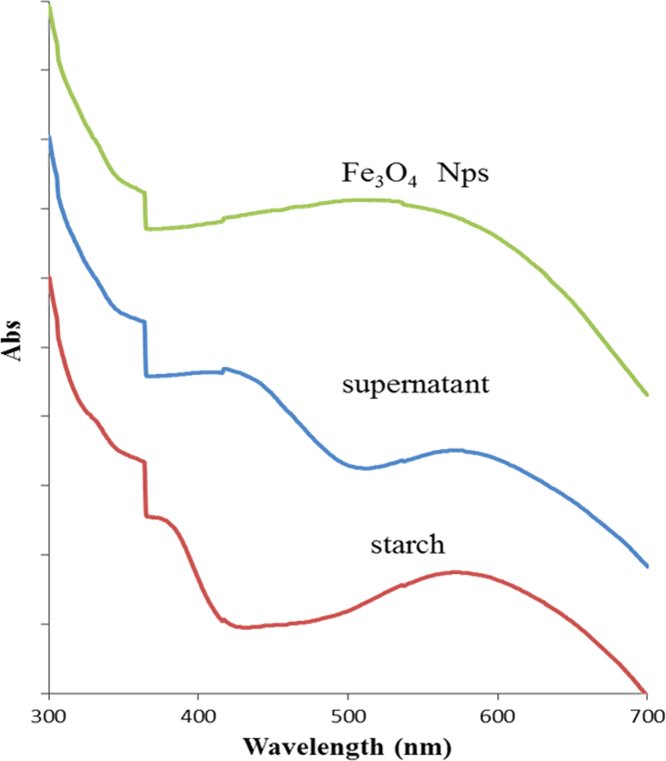
UV–vis Spectra of Fe3O4 NPs, supernatant and starch with iodine.